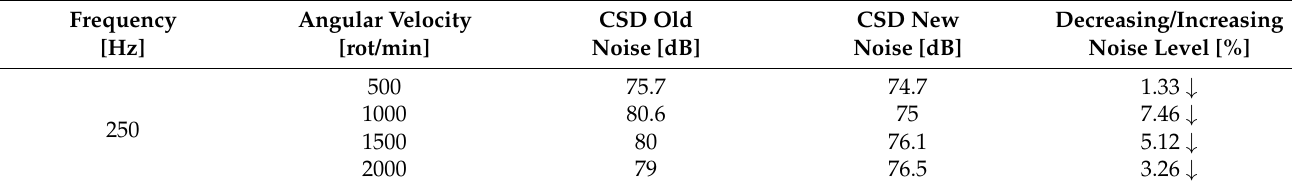
Table A4. Noise level on the front surface of